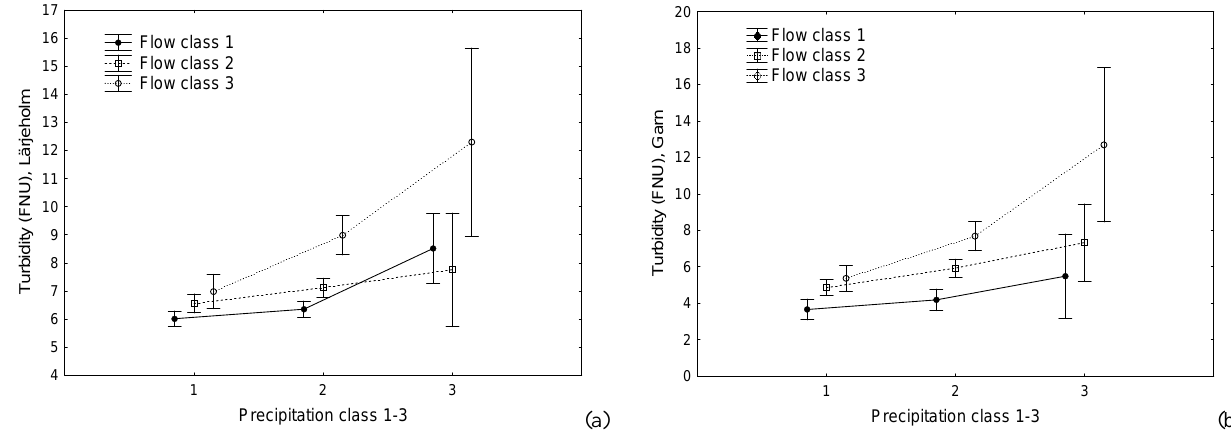
Fig. 10. Results of the factorial and main effect ANOVA analysis for the factors precipitation and discharge, and their influence on turbidity, measured at (a) L¨arjeholm (2002–2007) and (b) at Garn (2004–2006). Data on precipitation and discharge were scored into tree classes: zero precipitation is precipitation class 1; 0.1–20mm is precipitation class 2; 20.1–60mm is precipitation class 3, and 98–150m 3 s − 1 is flow class 1; 151–200m 3 s − 1 is flow class 2; and 201–258m 3 s − 1 is flow class 3. Vertical bars denote 0.95 confidence intervals, p <